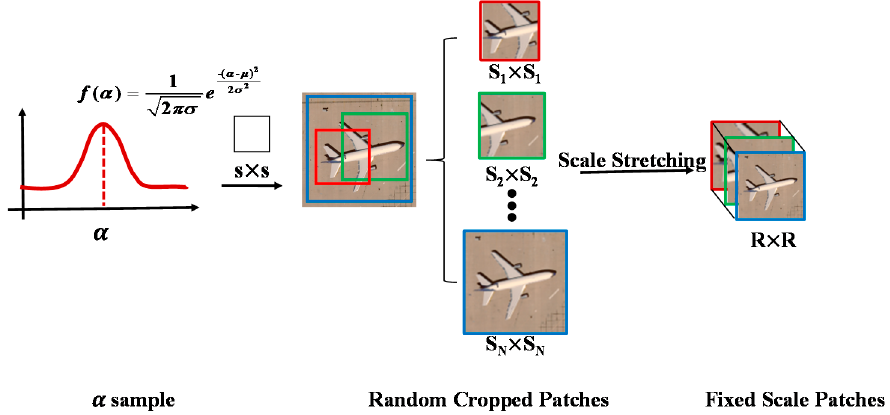
Figure 4. Random-scale stretching of a scene image.